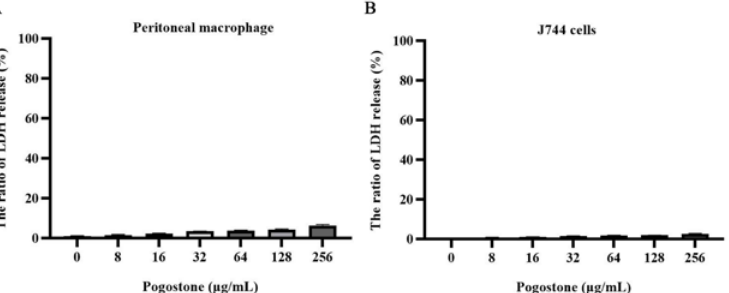
Figure 5. The cytotoxicity of pogostone (0–256 µ g/mL) was detected by LDH release assays. LDH release assays were performed on supernatants from murine peritoneal macrophages ( A ) and J774 cells ( B ).